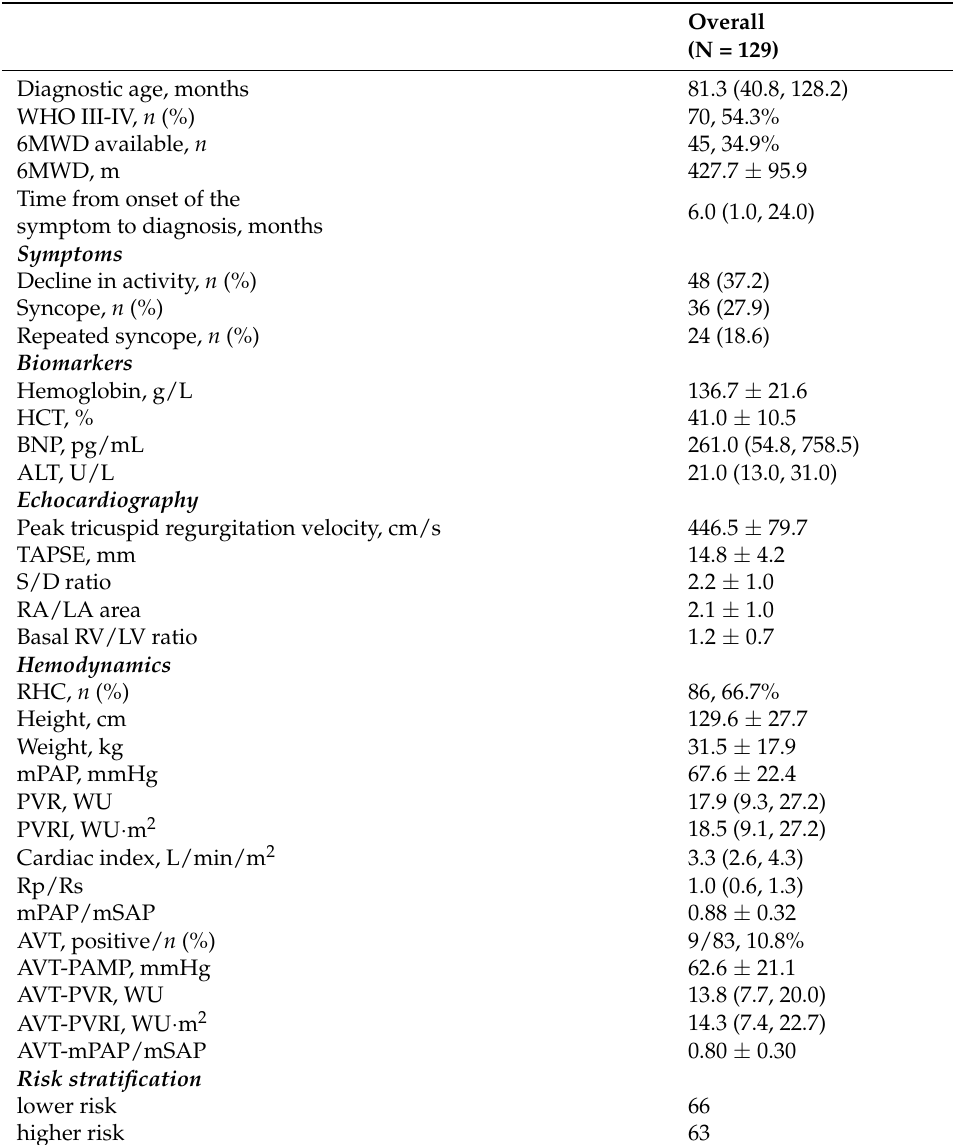
Table 1. Baseline clinical characteristics of patients with idiopathic pulmonary arterial hypertension and in